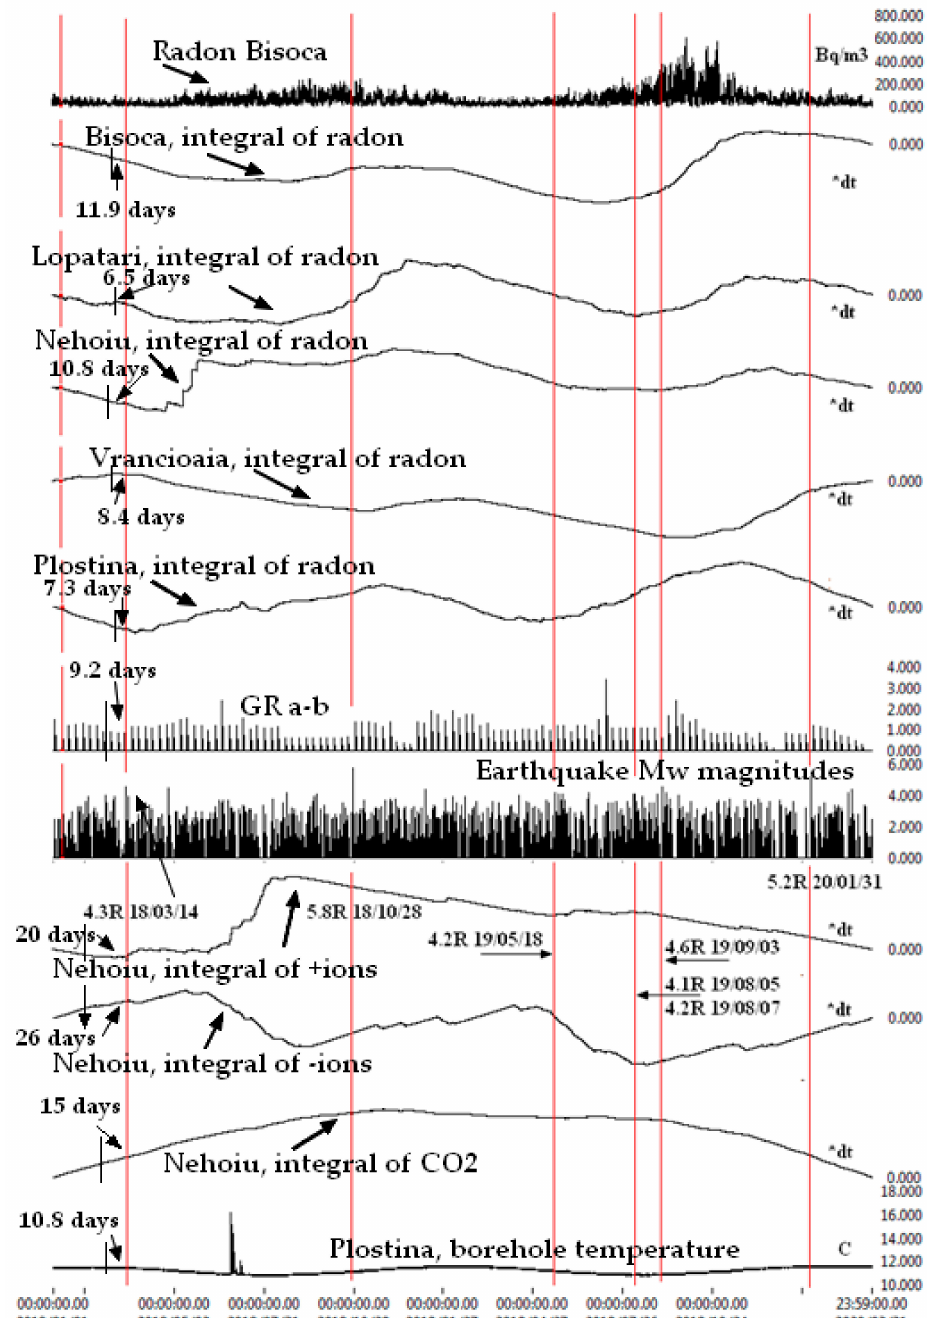
Figure 12. Vrancea area, radon, Gutenberg Richter (GR) a-b, Mw, Ions+/ − , CO 2 , temperature in